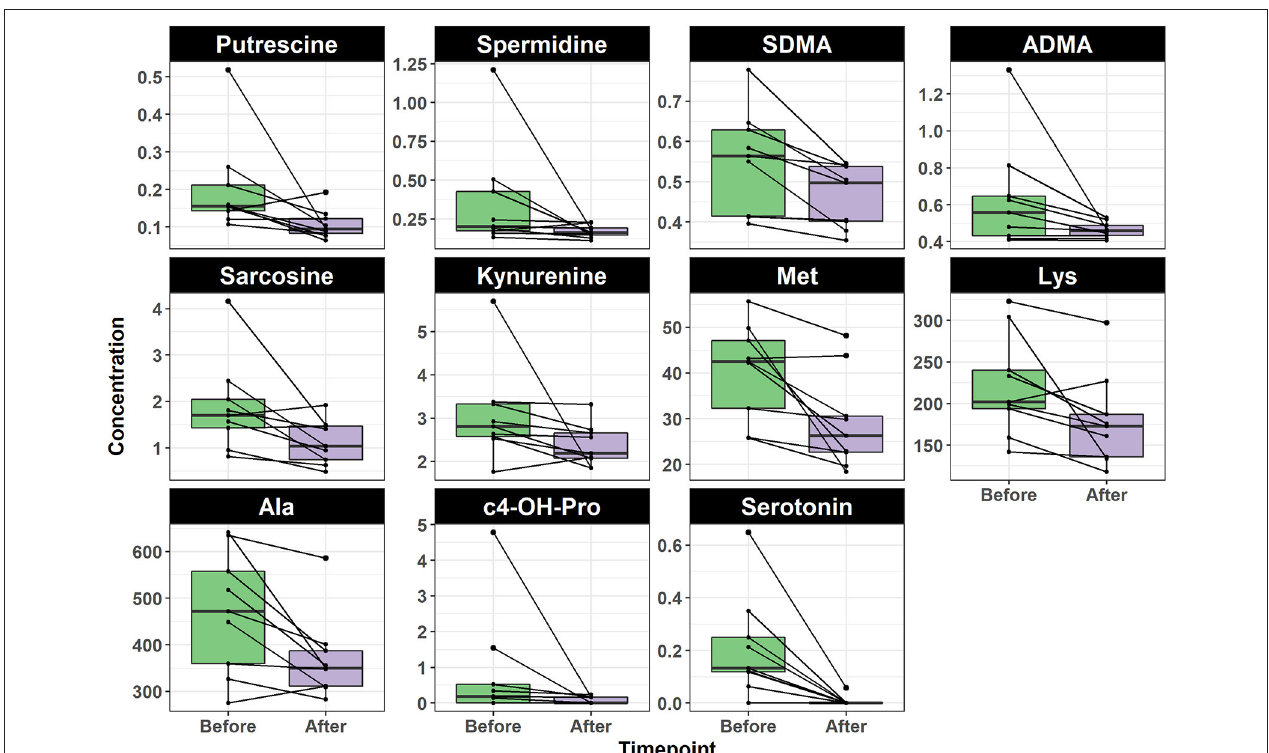
FIGURE 3 | Boxplot shows the concentration of amino acids metabolites before and after TC intervention. Paired samples are linked by a line for each subject. All shown metabolites were significantly decreased after intervention (adjusted p < 0.05). ADMA, asymmetric dimethylarginine; Ala, alanine; c4-OH-Pro, cis-4-hydroxyproline; Lys, lysine; Met, methionine; SDMA, symmetric